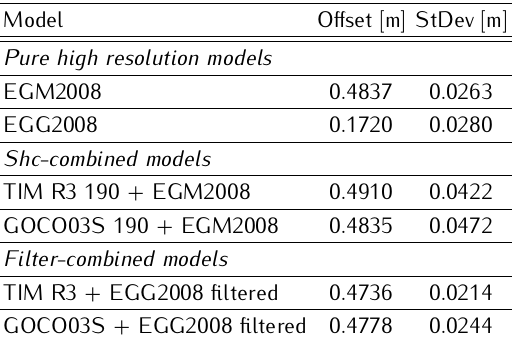
Table 2. Validation of gravity field models vs. observed height anomalies at 954 points in Germany. The EGM2008 was developed through d/o